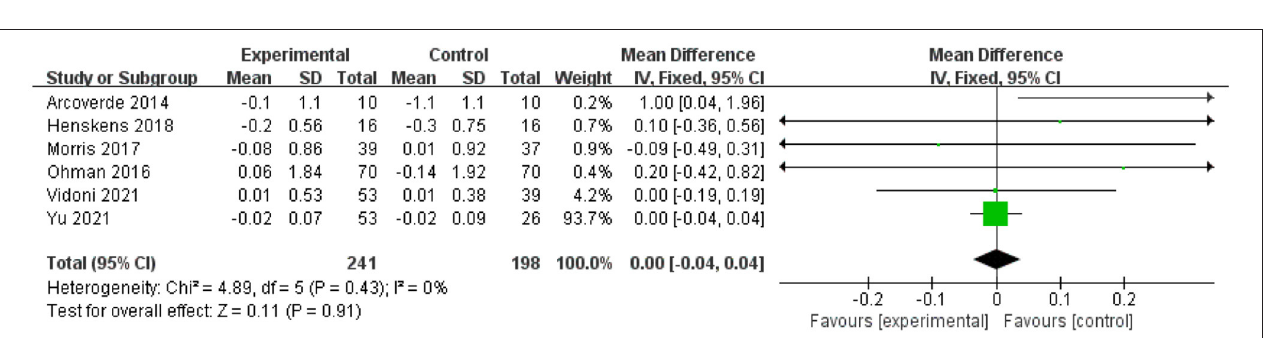
FIGURE 5 | Forest plot for physical exercise interventions on cognition function (MoCA).